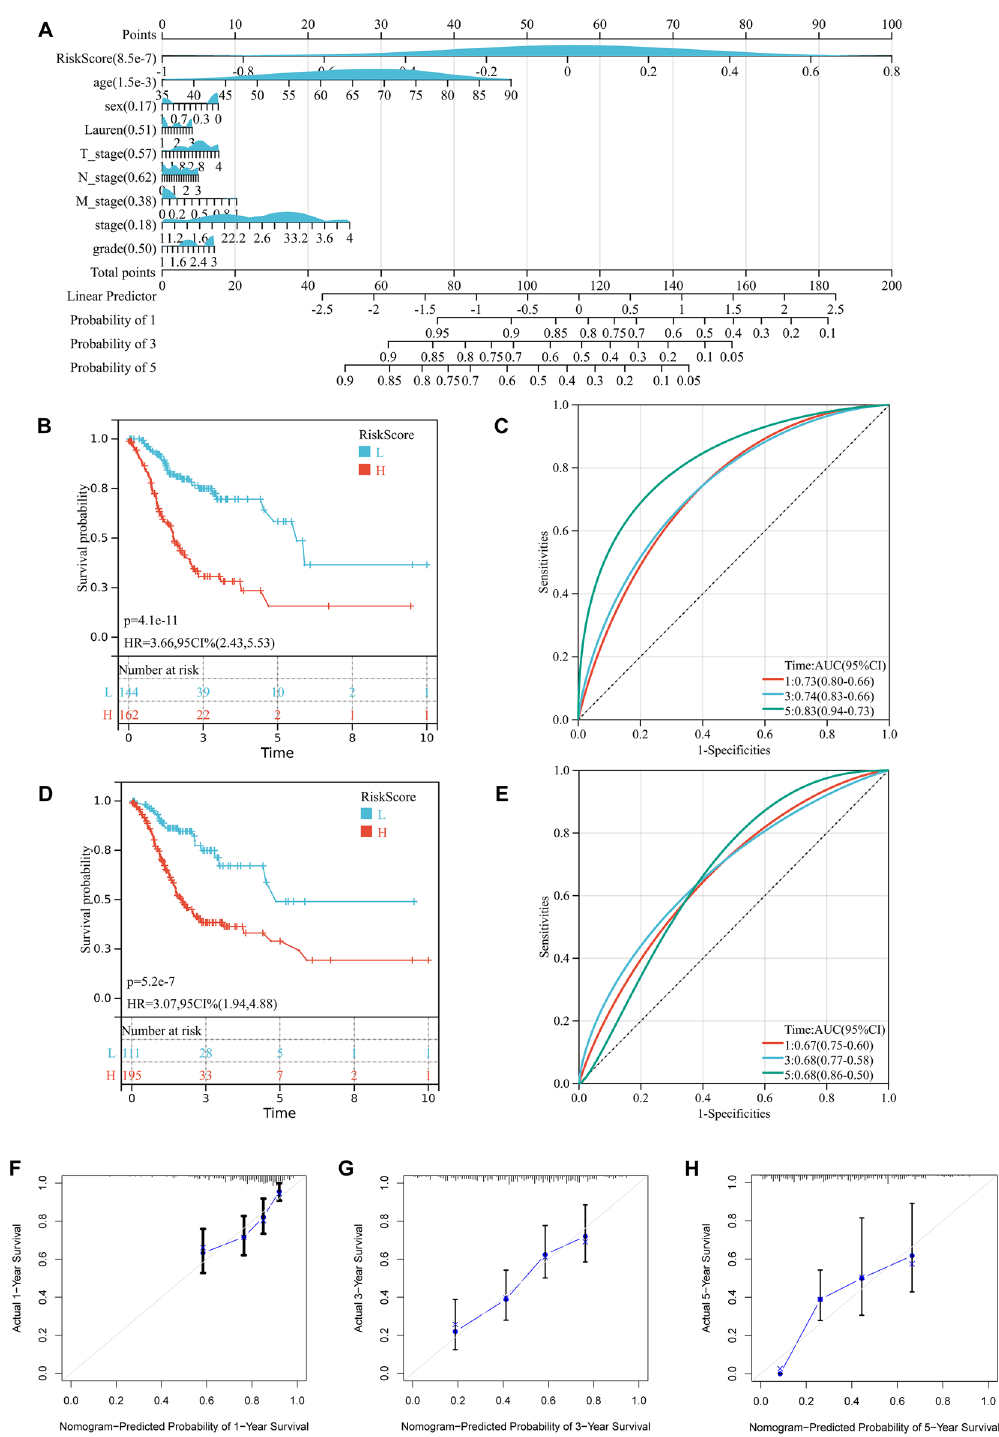
Figure 3. The nomogram was generated to improve risk stratification and estimate survival probability. ( A ) The comprehensive nomogram for predicting probabilities of gastric cancer patients with 1-, 3- and 5-year overall survival in TCGA-STAD dataset. ( B ) Kaplan–Meier analyses of overall survival for this nomogram. ( C ) Received operating characteristic analyses of 1-, 3- and 5-year overall survival for this nomogram. ( D ) Kaplan– Meier analyses of overall survival for the nomogram without hypoxia-related risk score. ( E ) Received operating characteristic analyses of 1-, 3- and 5-year overall survival for the nomogram without hypoxia-related risk score. ( F–H ) The calibration plots for predicting gastric cancer patients with 1-, 3- and 5-year overall survival in